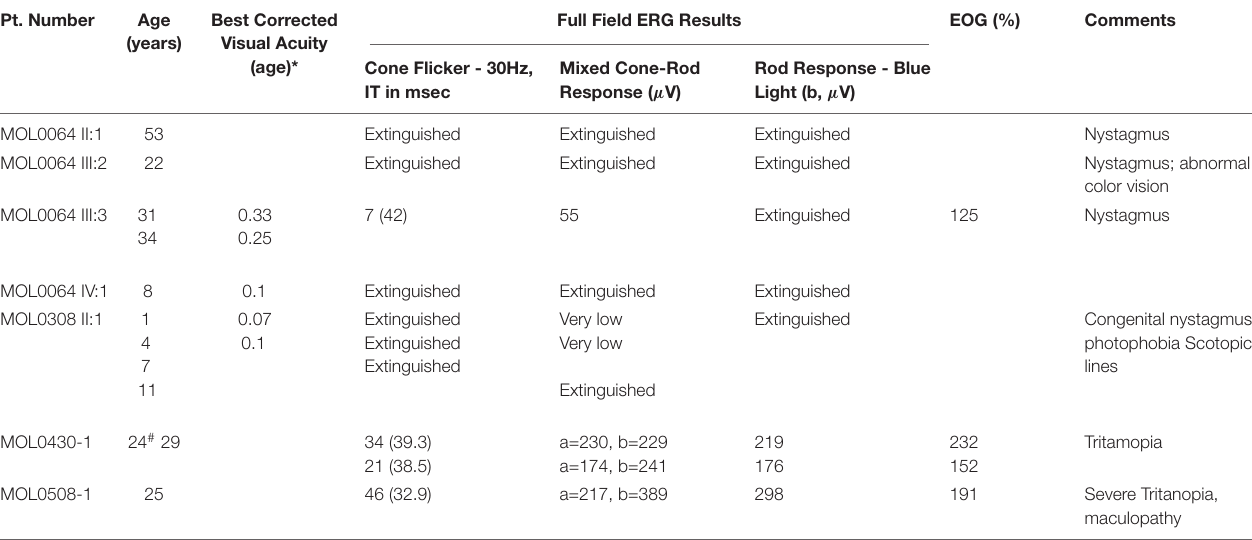
TABLE 1 | Clinical data of patients with GUCY2D mutation. Pt.